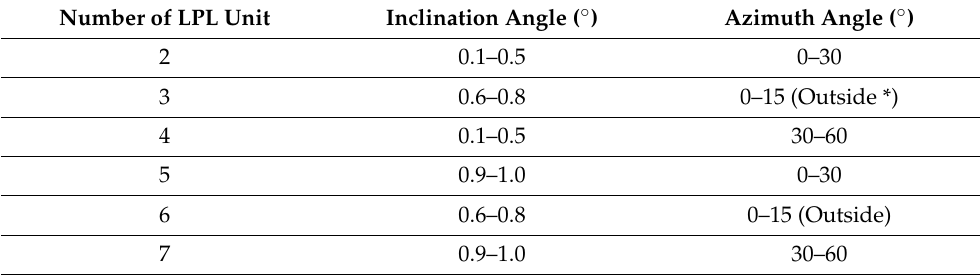
Table 7. The obtained angle errors of the seven LPL units by the automatic identification verification